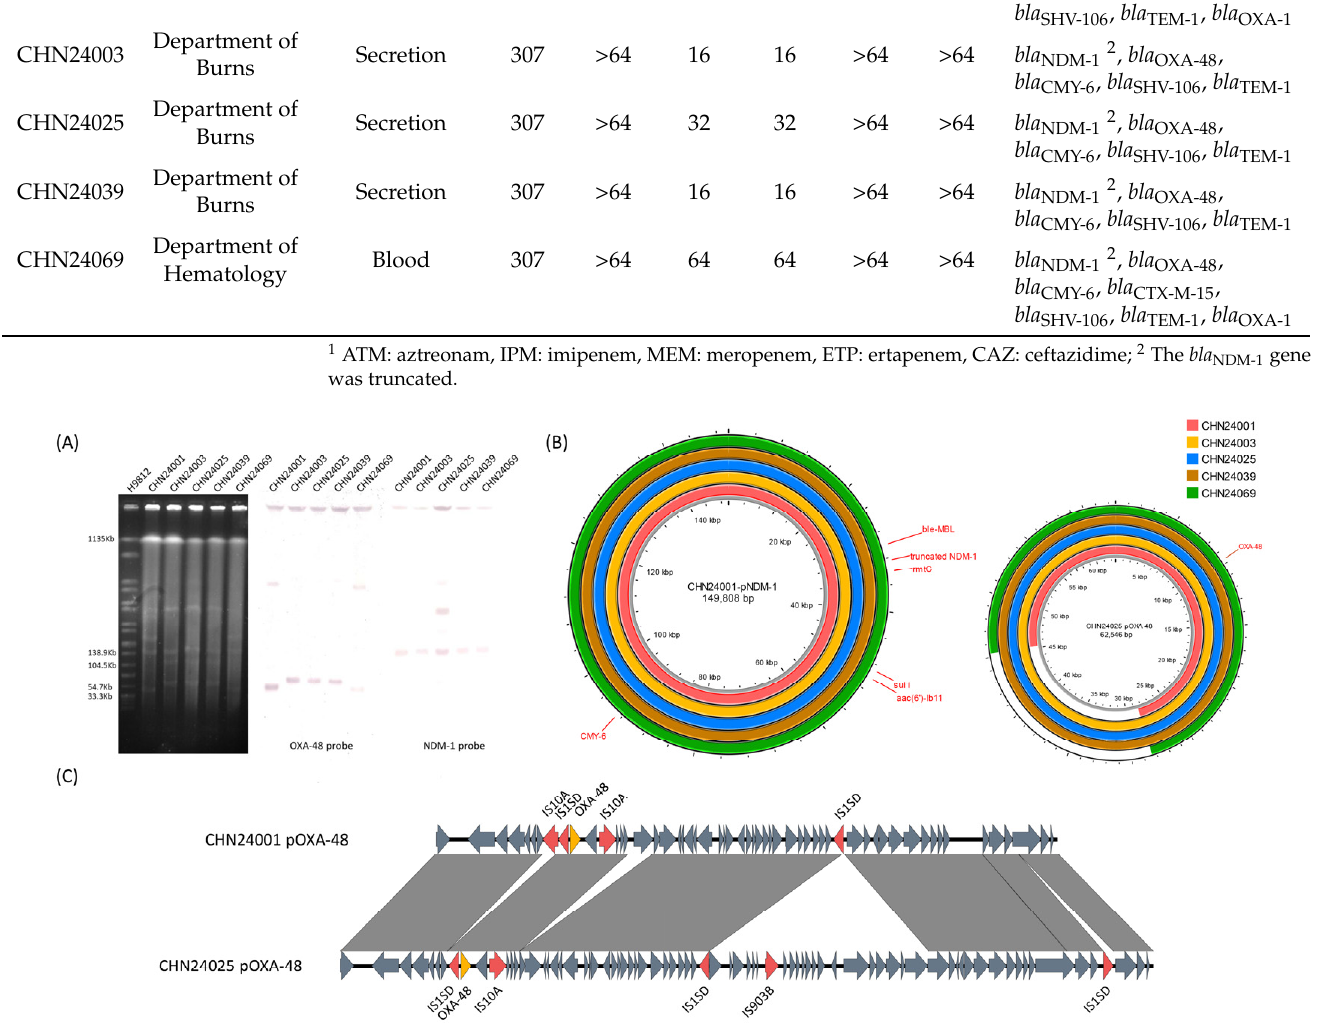
Figure 2. ( A ) The S1-digested plasmid DNA and the Southern blotting of CHN24001, CHN24003, CHN24025, CHN24039, and CHN24069 with the bla NDM-1 and bla OXA-48 probes. ( B ) Comparison of pNDM-1 and pOXA-48 among these isolates. The red ring represents CHN24001, the yellow ring represents CHN24003, the blue ring represents CHN24025, the brown ring represents CHN24039, and the green ring represents CHN24069. Antimicrobial resistance genes are labelled in the figures. ( C ) The comparison of pOXA-48 between CHN24001 and CHN24025. The red arrows represent mobile genetic elements (MGEs), the yellow arrows represent antimicrobial resistance genes, and the grey arrows represent open reading frames (ORFs).